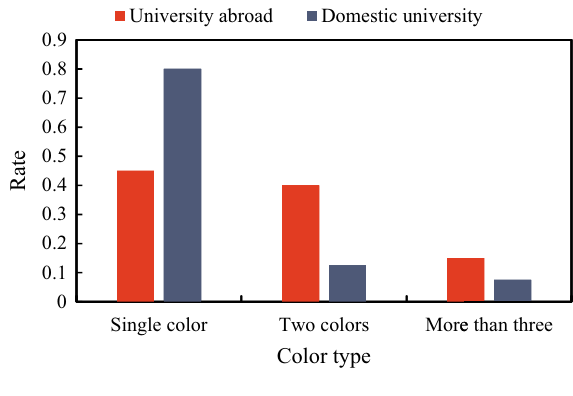
Figure 2: Color statistics of the